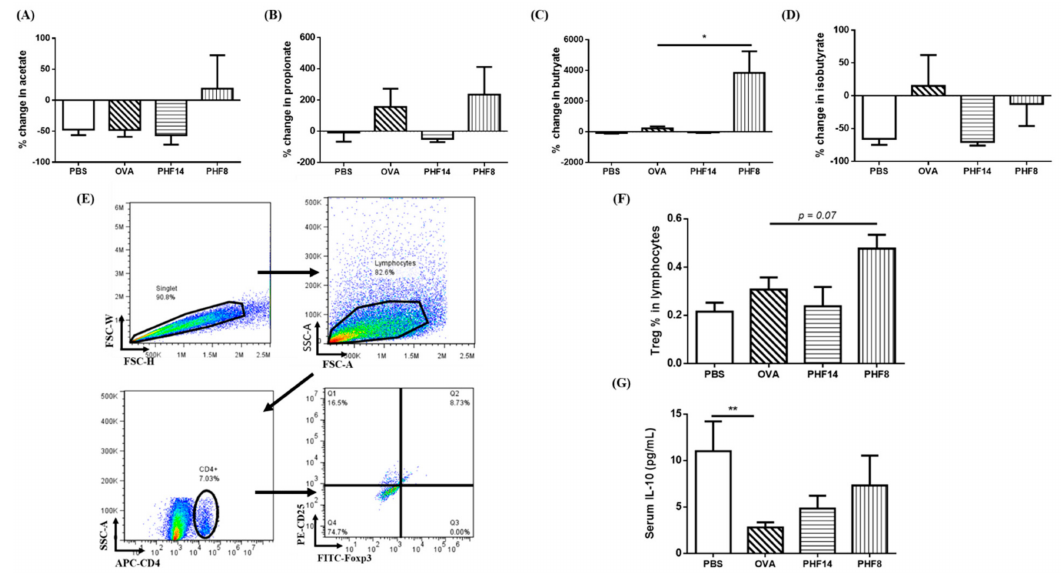
Figure 5. Effects of PHF treatment on short chain fatty acids (SCFAs) content in stool, modulation on the CD4 + CD25 high Foxp3 + Treg cells population and systemic IL-10 level of allergic asthmatic mice. Stool samples were collected on day 1 before sensitization and on day 24 before sacrifice. GC-MS quantification was performed to evaluate the concentration of SCFAs in the stool samples. Percentage changes of ( A ) acetate, ( B ) propionate, ( C ) butyrate and ( D ) isobutyrate between day 1 and day 24 are shown in bar charts with mean + SEM. ( n = 3–5). ( E ) Gating strategy of the splenic CD4 + CD25 high Foxp3 + Treg cells was shown by representative dot-plots using flow cytometry. ( F ) Population of splenic CD4 + CD25 high Foxp3 + Treg cells in the lymphocytes was determined by flow cytometry. ( G ) The serum level of IL-10 was measured by Bio-plex pro assay. Results were shown in bar charts with mean + SEM ( n = 4–8). * p < 0.05, when compared with the OVA control group. PBS: healthy control; OVA: OVA-induced allergic asthmatic control; PHF14: mice with 14-day PHF treatment; PHF8: mice with 8-day PHF